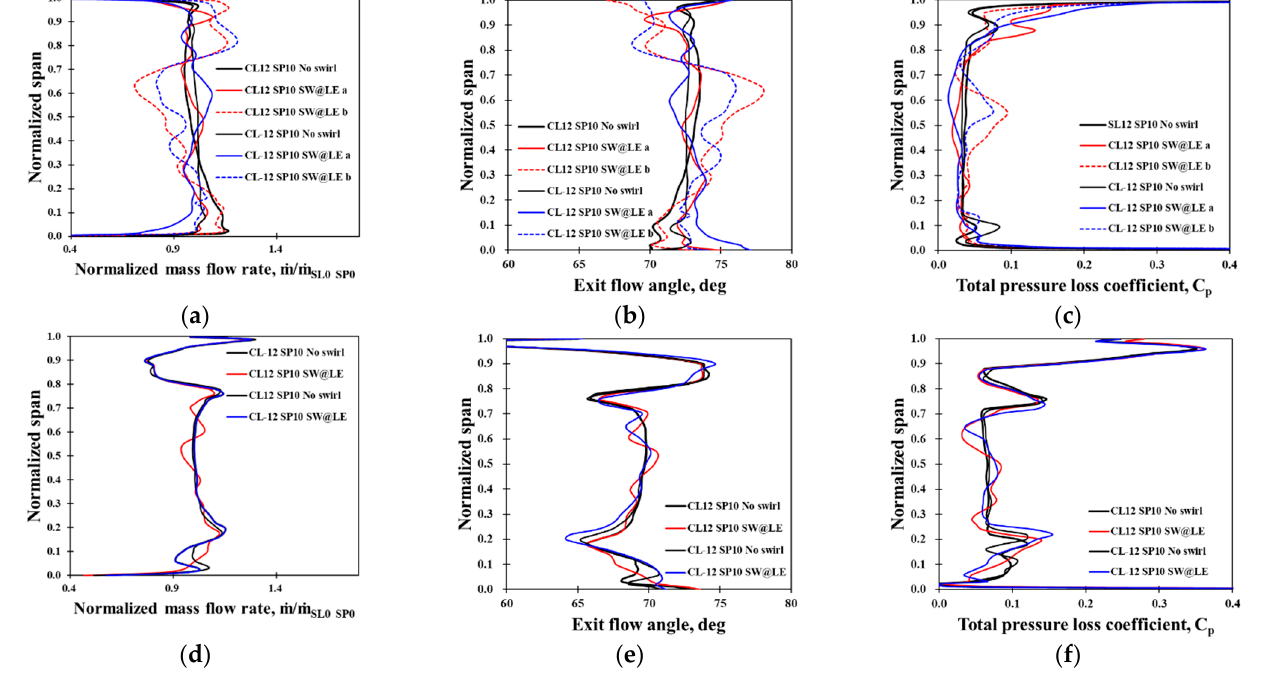
Figure 31. Comparison of circumferentially averaged mass flow rate ( a , d ), exit flow angle ( b , e ), and total pressure loss coefficient ( c , f ) of the CL12 SP10 and CL − 12 SP10 model due to swirl clocking.